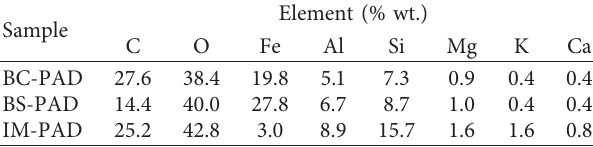
Table 1: EDXs analysis of untreated PAD minerals. Element (% Sample